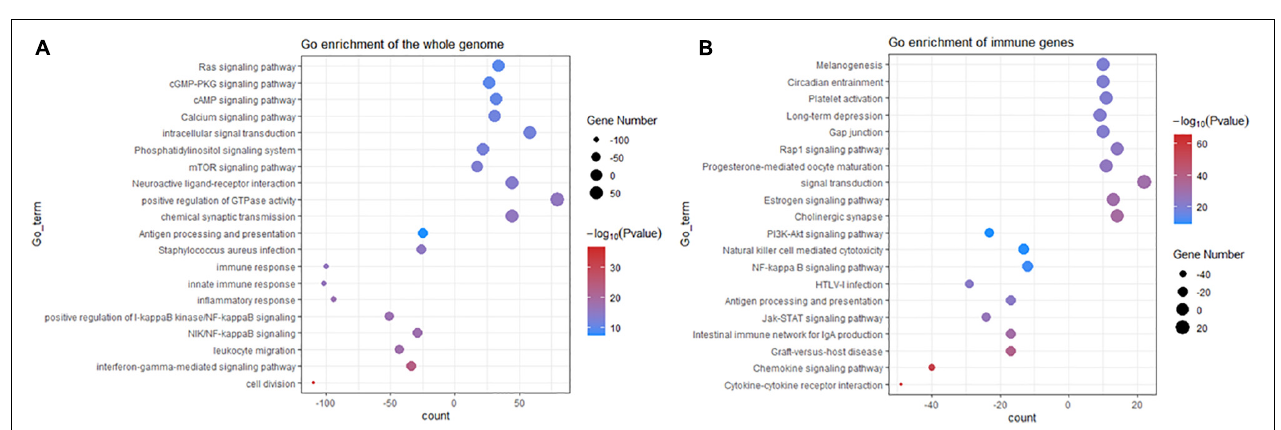
FIGURE 1 | TERT mutation pattern and prognostic value in glioma from TCGA dataset. TERT mutation radio in glioma according to WHO grade (A) , IDH status (B) or 1p-19q co-deletion (C) ; Kaplan-Meier analyses of overall survival according to TERT status ( D , all cases; E , glioblastoma; F , all cases with IDH mutant; G , all cases with IDH wild type); discriminative power of TERT was assessed with Kaplan-Meier plotting method and the Log-rank test. Significant p < 0.05.